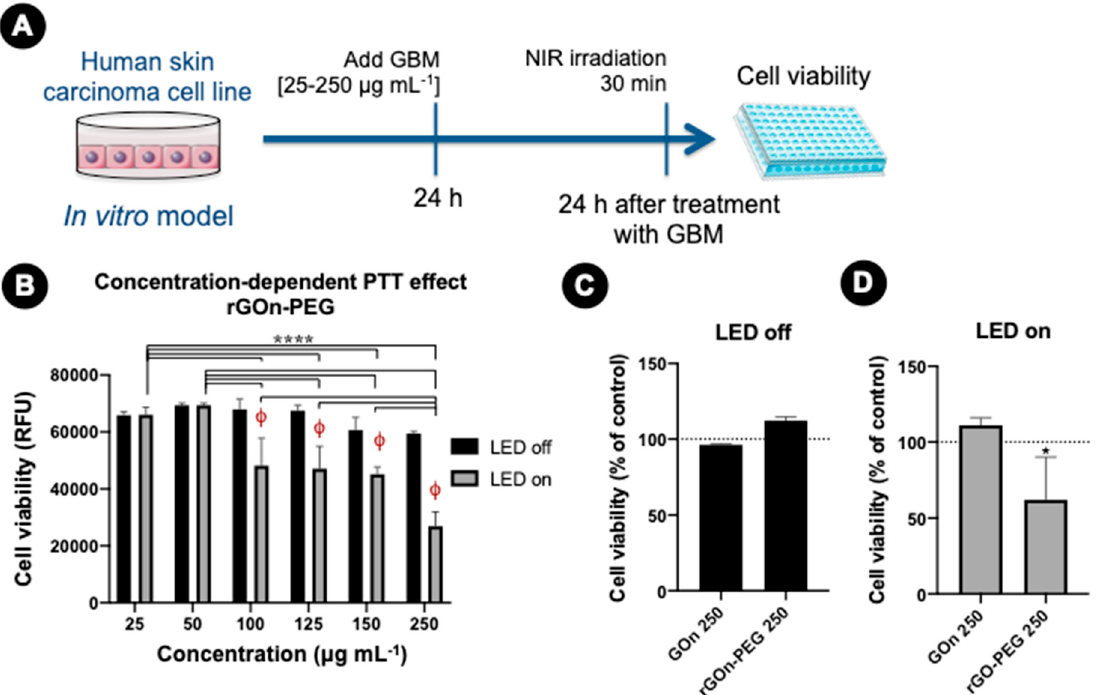
Figure 8. NIR irradiation and in vitro photothermal effect. ( A ) Experimental set-up. One day (24 h) after seeding, human skin carcinoma cells (A-431) were treated with different concentrations of GOn and rGOn-PEG and incubated for an additional 24-h period, prior to NIR irradiation for 30 min and resazurin assay. ( B ) Cellular viability determined using resazurin assay. Results are shown as relative fluorescence units (RFU). Statistically significant differences are shown as ****, p < 0.0001, φ , p < 0.0001 in comparison to LED off condition. ( C ) Cellular viability without NIR irradiation in the presence of 250 μ g mL − 1 of GOn or rGO-PEG. Results are normalized with respect to values of the control without GBM ( D ) Cellular viability upon NIR irradiation in the presence of 250 μ g mL − 1 of GOn or rGOn-PEG. Results are normalized with respect to values of the control without GBM. Statistically significant differences are shown as *, p < 0.05.